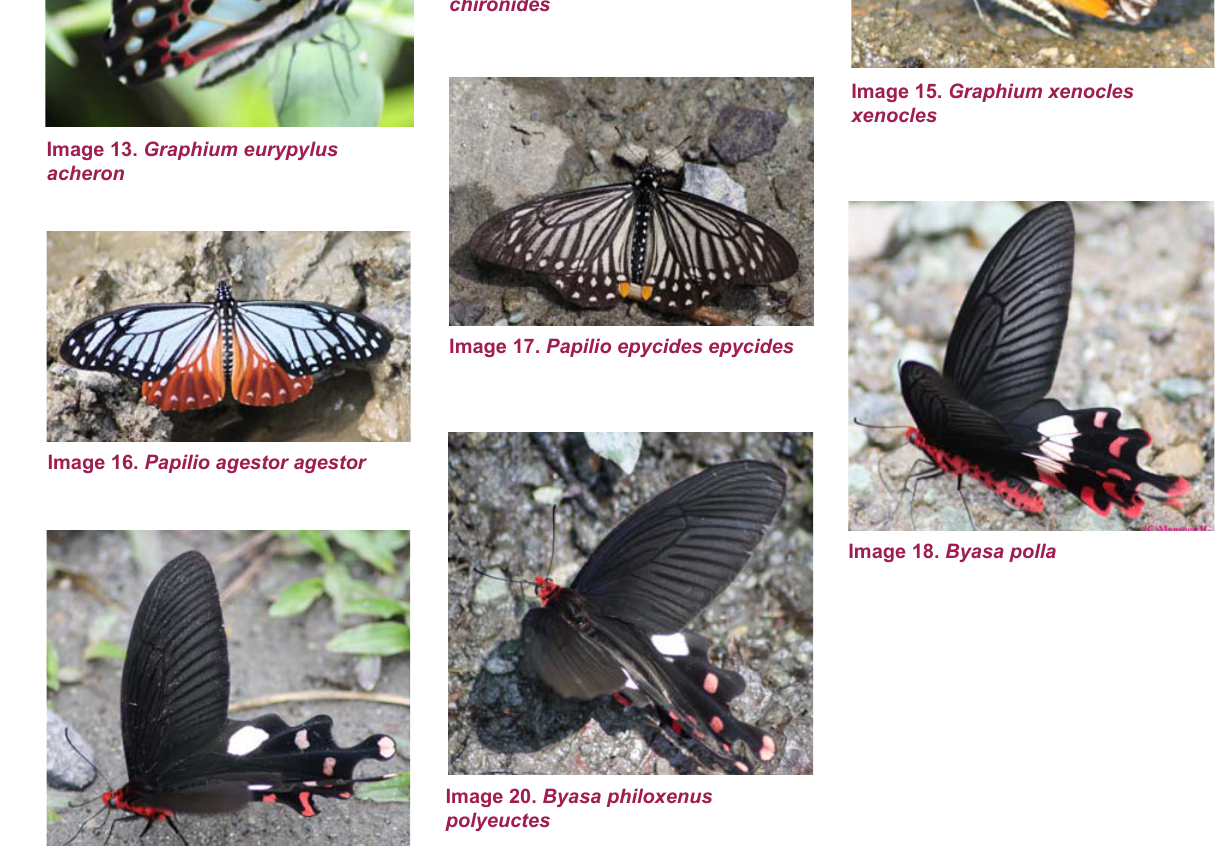
Image 14. Graphium chironides chironides